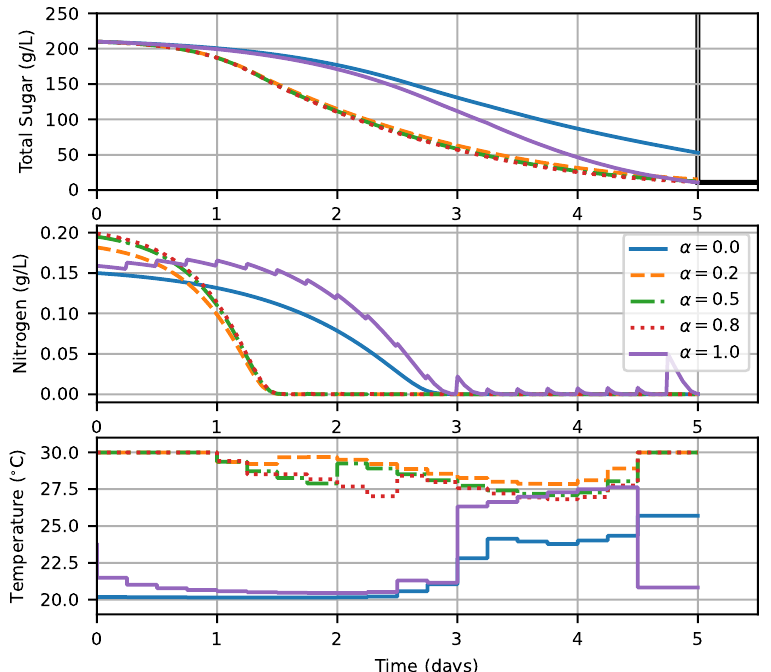
Figure 2. Optimal control simulations for free nutrition strategies. Black line in total sugar graph corresponds to the desired digging-out